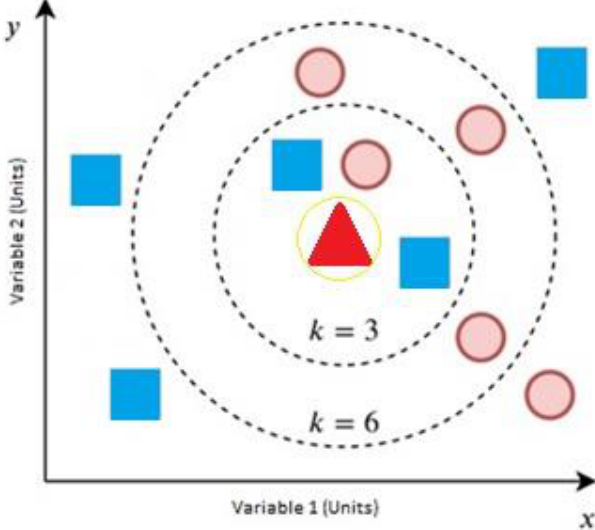
Figure 6. KNN decision example; adapted from [37].